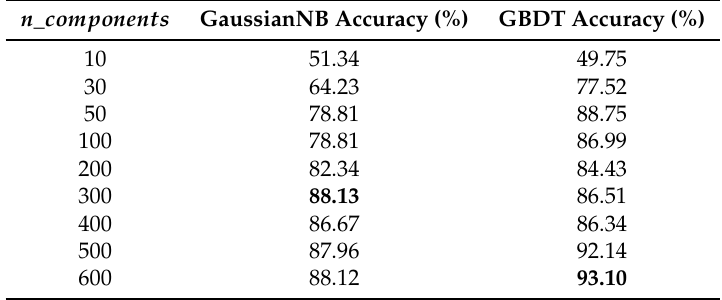
Table 8. The classification results based on the different number of principal